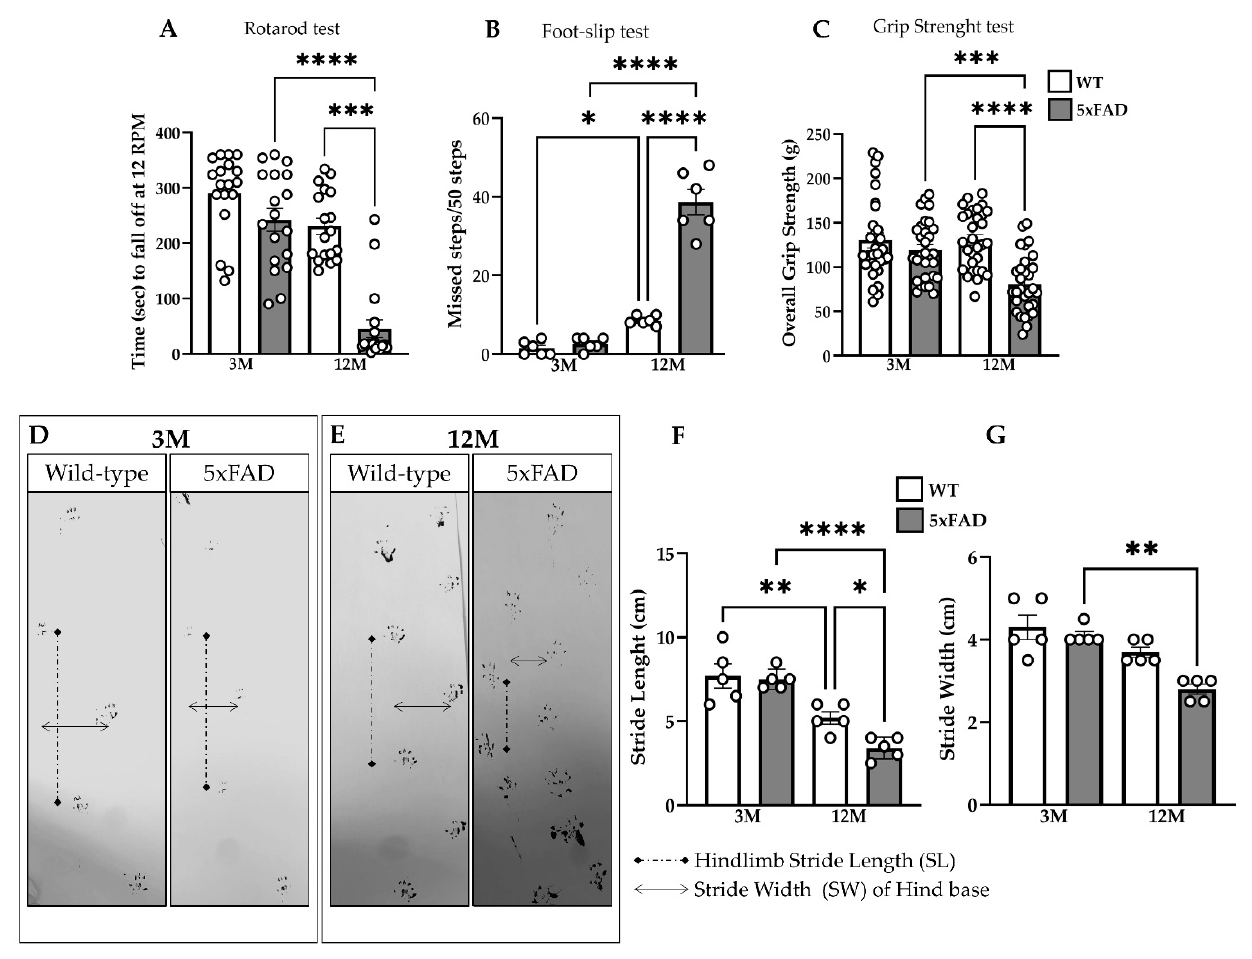
Figure 3. Decline of motor function in 12M 5xFAD mice. ( A ) Rotarod testing at 12 rotations per minute (rpm) showed significantly worse performance of 12M 5xFAD compared with WT mice of the same age and with the 3M 5xFAD mice. ( B ) Foot-slip test showed more missed steps in 12M 5xFAD compared with WT littermates and 3M 5xFAD mice. ( C ) Grip strength evaluation revealed significantly reduced strength in old 5xFAD mice compared with the WT group and with the 3M 5xFAD mice. ( D , E ) Representative photographs of footprints from 5xFAD and WT mice of 3 and 12 months of age. Quantitative footprint analysis revealed that 12M 5xFAD mice had an overall more severe gait phenotype resulting from reduced stride length ( F ) and stride width ( G ) of hind paws compared with WT animals of the same age. Statistical analysis was performed by one-way ANOVA followed by Kruskal–Wallis multiple comparisons for all the behavioral tests ( n = 6 for all genotype and age groups). The same 3M and 12M mice were used for all the experiments. Data are presented as mean ± SD. Significance is given as: * p < 0.05, ** p < 0.01, *** p < 0.001, **** p <